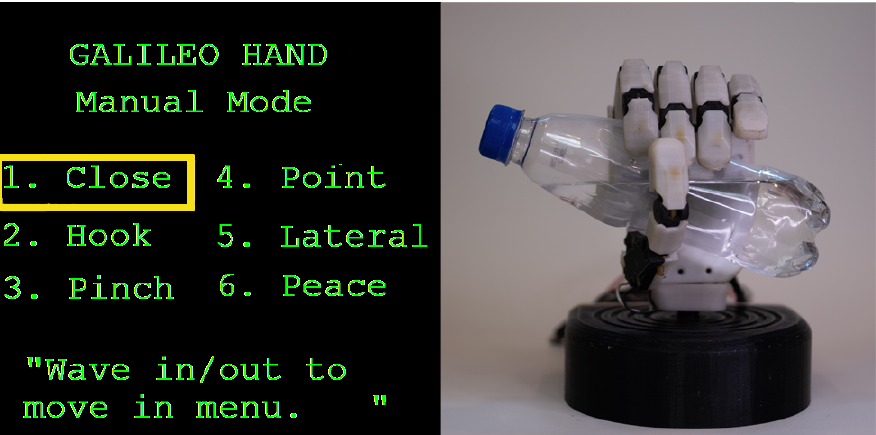
Figure 6. Galileo Hand’s graphical menu ( left ) and the prosthesis performing the action “Close” ( right